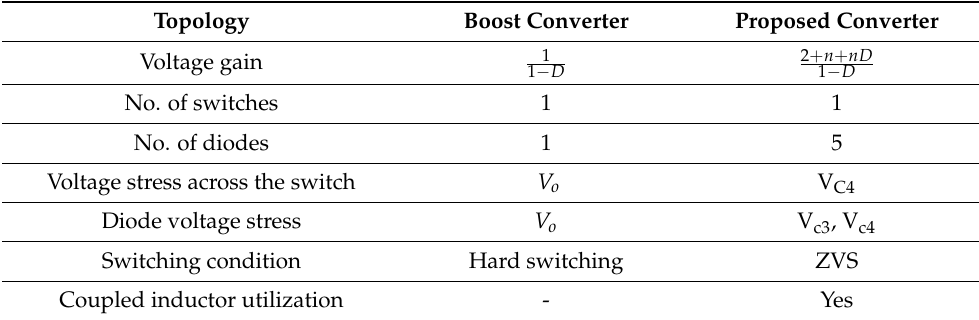
Table 1. Performance comparison with traditional converter.